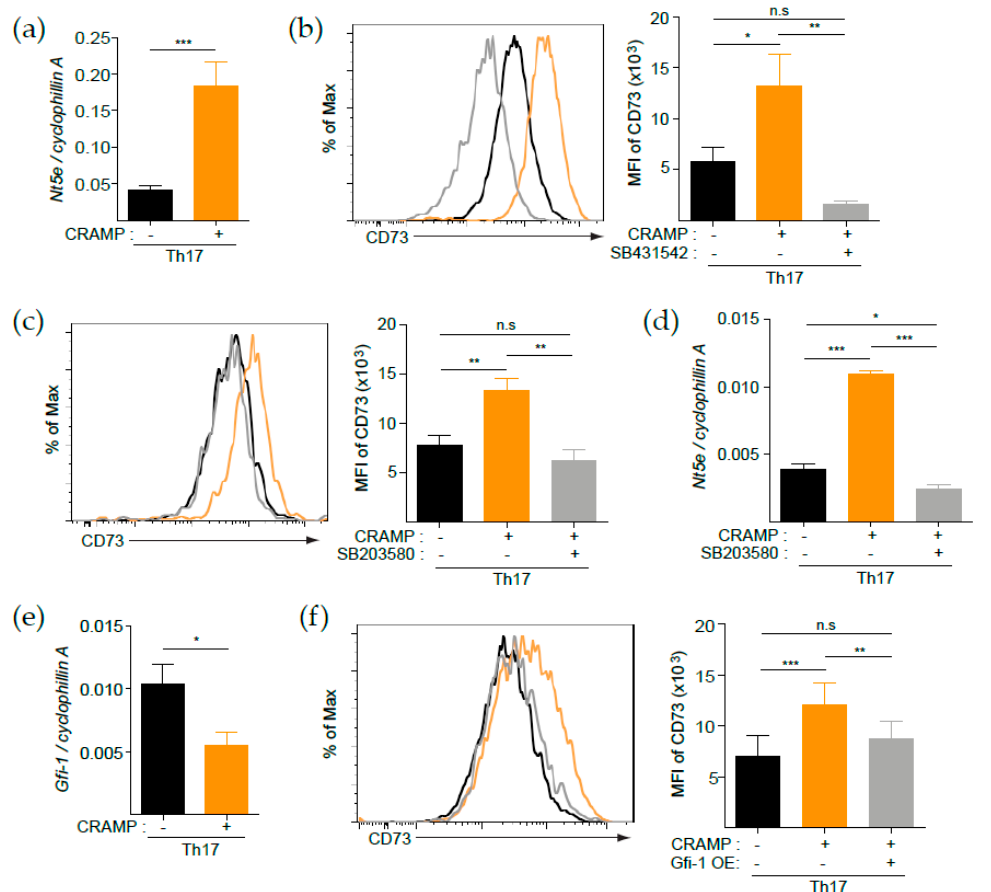
Figure 4. p38 is responsible for CRAMP-mediated synergistic induction of CD73. ( a – e ) Th17 cells were indicated. ( a ) RT-PCR analysis of Nt5e (CD73) in CRAMP-stimulated Th17 cells ( n = 4). Flow cytometry analysis of CD73 expression on Th17 cells treated with SB431542 (TGF- β receptor inhibitor) ( b ) or SB203580 (p38 inhibitor) ( c ); the bar graph indicates the mean fluorescent intensity (MFI) value of CD73 ( n = 3). ( d ) RT-PCR analysis of Nt5e (CD73) in SB203580-treated Th17 cells ( n = 3). ( e ) RT-PCR analysis of Gfi-1 in CRAMP-treated Th17 cells ( n = 4). ( f ) Flow cytometry analysis of CD73 on retroviral Gfi-1 overexpressed (Thy1.1 + ) Th17 cells; the bar graph indicates the mean fluorescent intensity (MFI) value of CD73 ( n = 3). * p < 0.05, ** p < 0.01 *** p < 0.001 and n.s—not significant (Student’s t-test or one-way ANOVA with post hoc Tukey